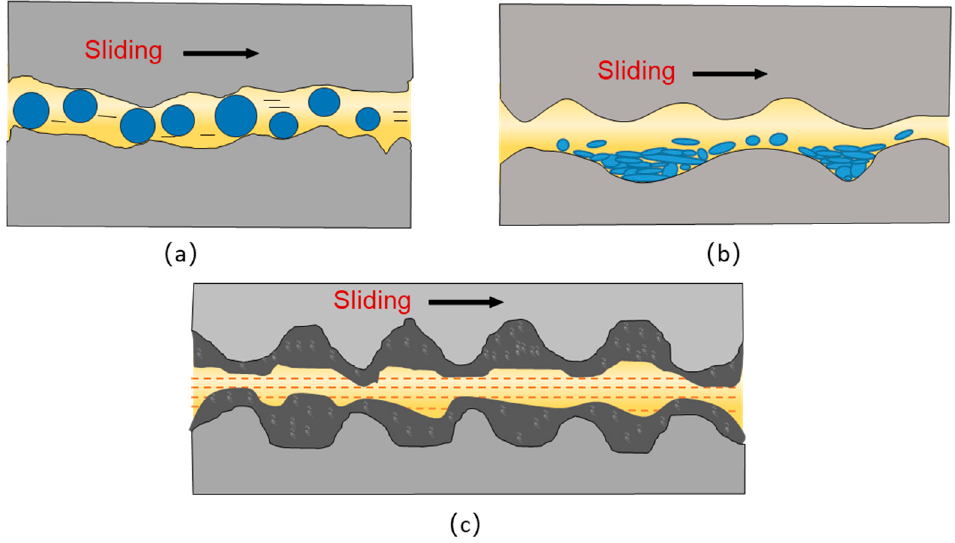
Figure 2. Diagram of the lubrication mechanism of zero-dimensional nanoadditive: ( a ) “rolling bearing” effect, ( b ) mending effect, ( c ) film-formation mechanism.